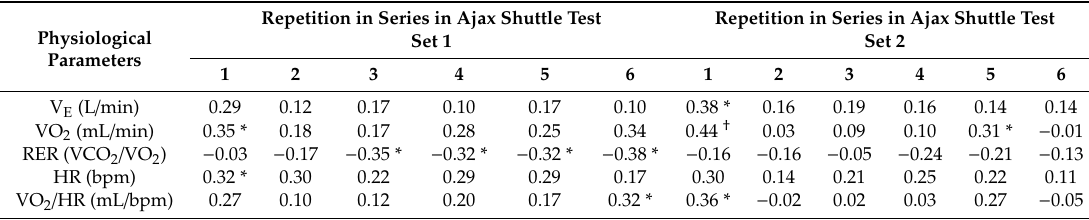
Table 6. Correlations between some physiological variables at the predicted VO 2max level and time required for various repetitions of AST and CST.